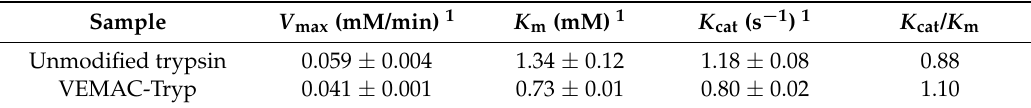
Table 1. Enzyme kinetic parameters determined by Hanes–Woolf plots.